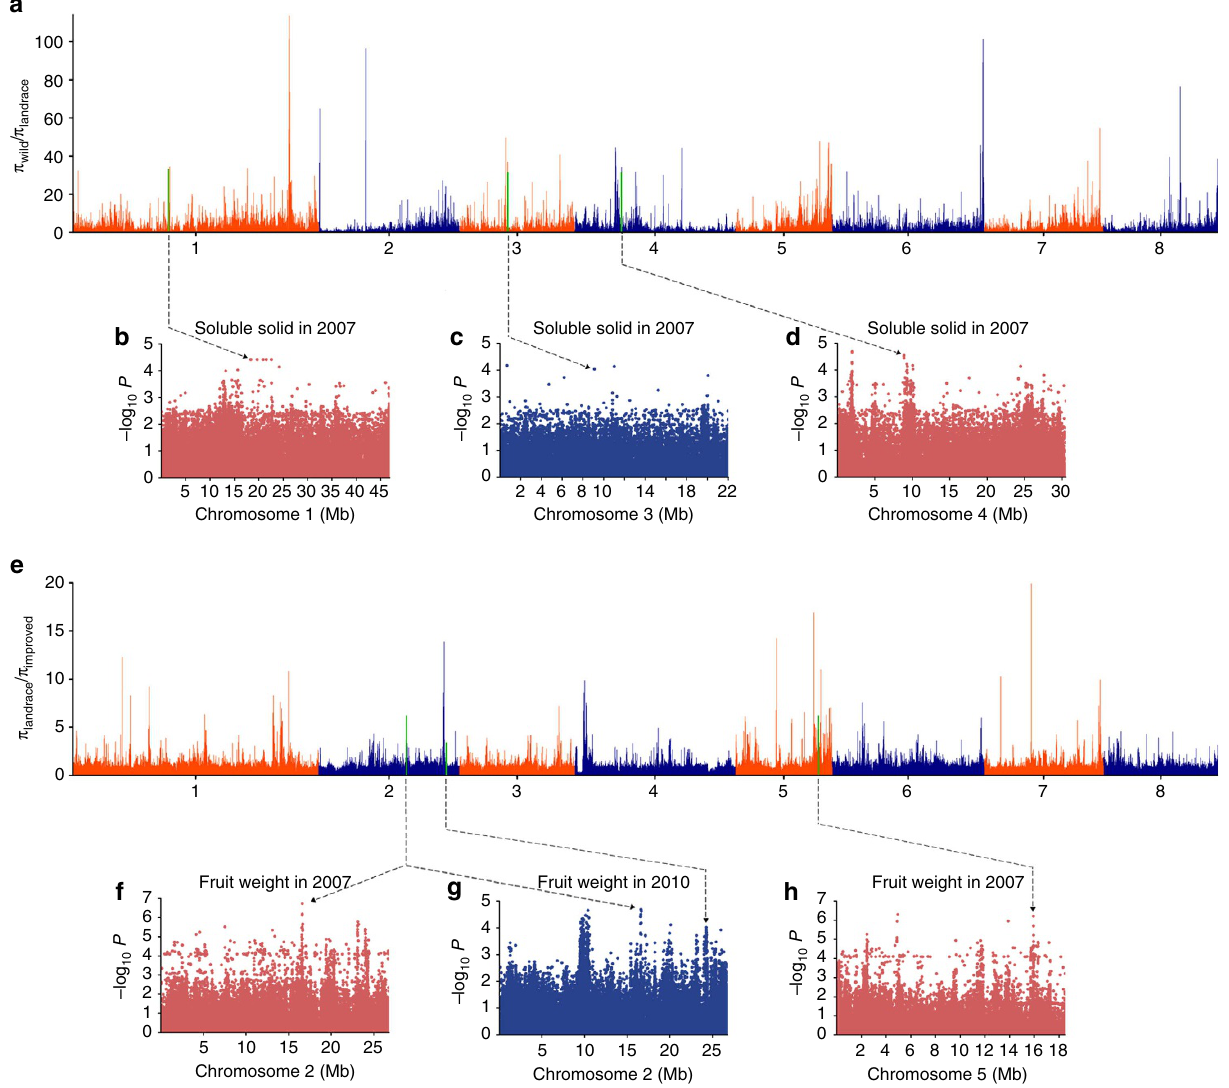
Figure 3 | Whole-genome screening for predicted selective sweeps that occurred during peach domestication and improvement. ( a ) Whole-genome screening of the selective sweeps predicted to have occurred during peach domestication, according to the p wild / p landrace values calculated for the eight chromosomes. The selective sweeps that overlapped with characterized GWAS loci are shown in green. ( b – d ) The three strong selective sweeps associated with soluble solid content in 2007 in scaffold_1: 18,146,487bp, scaffold_3: 9,101,540bp, and scaffold_4: 8,873,368bp. The x axis shows the genomic position, and the y axis shows the significance expressed as (cid:3) log 10 P value. ( e ) Whole-genome screening of the selective sweeps predicted to have occurred during peach improvement, according to the p landrace / p improved values found along the eight chromosomes. The selective sweeps that overlapped with characterized GWAS loci are shown in green. ( f ) The strong selective sweep associated with fruit weight in 2007 in scaffold_2: 16,609,769bp. ( g ) The two selective sweeps associated with fruit weight in 2010 in scaffold_2: 16,609,769bp and scaffold_2: 24,271,176bp, respectively. ( h ) The selective sweep associated with fruit weight in 2007 in scaffold_5: